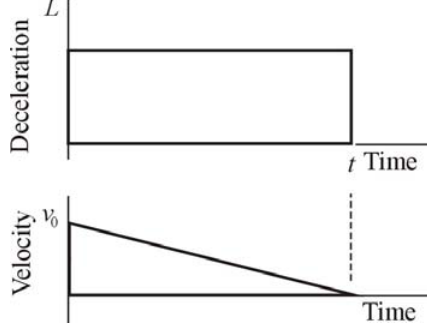
Fig 10. Rate of deceleration with a triangular form (No 3) Term